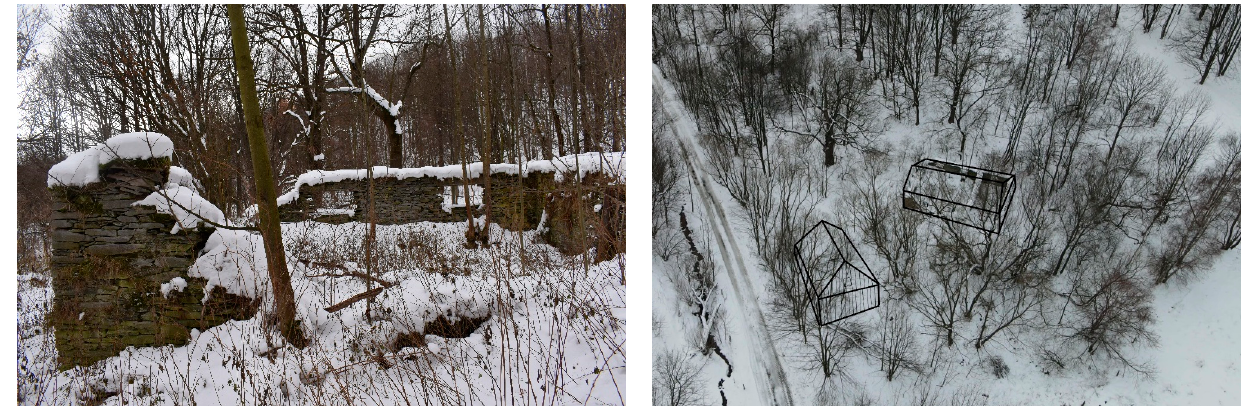
Figure 6. Building ruins (2021) and visualization. Malý Valštejn (Klein Wallstein), district of